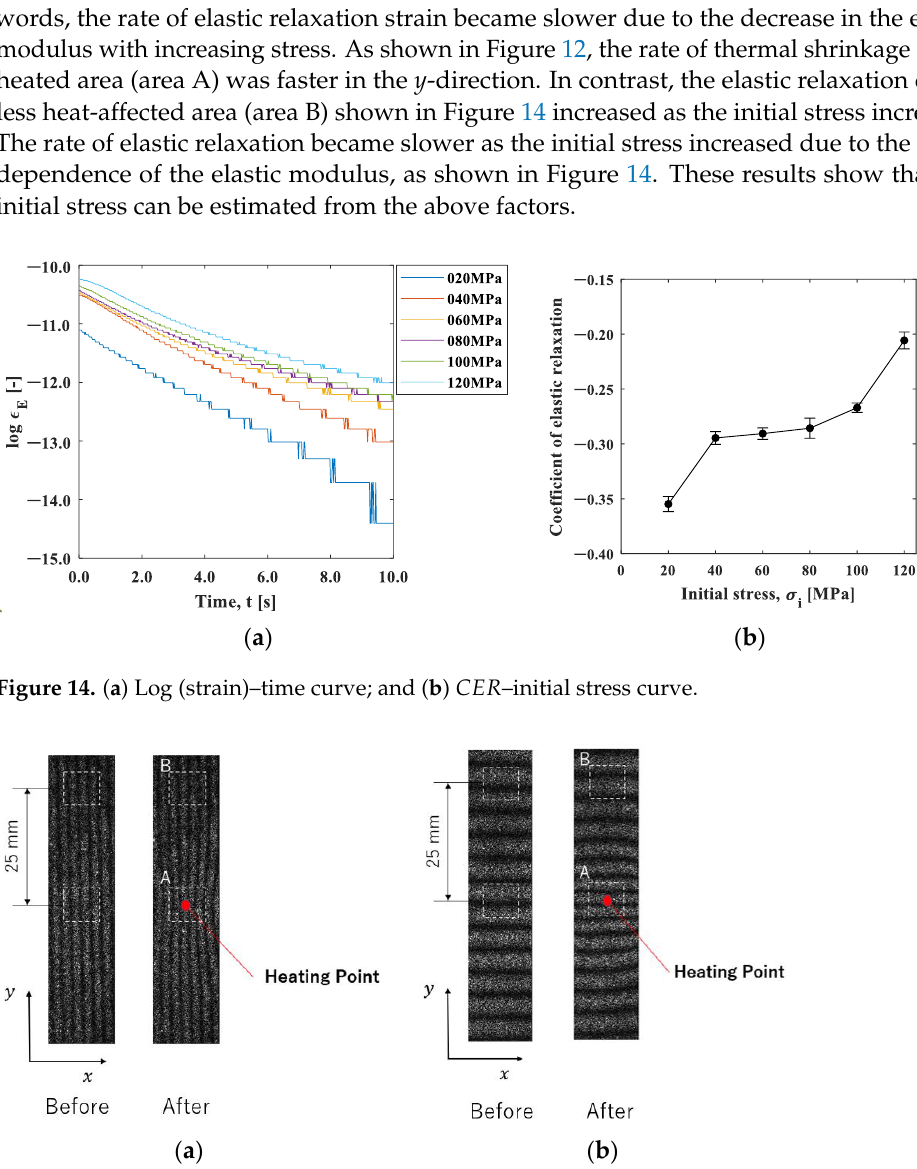
Figure 15. Fringe images before and after the spot heating, in the ( a ) x-direction and ( b )